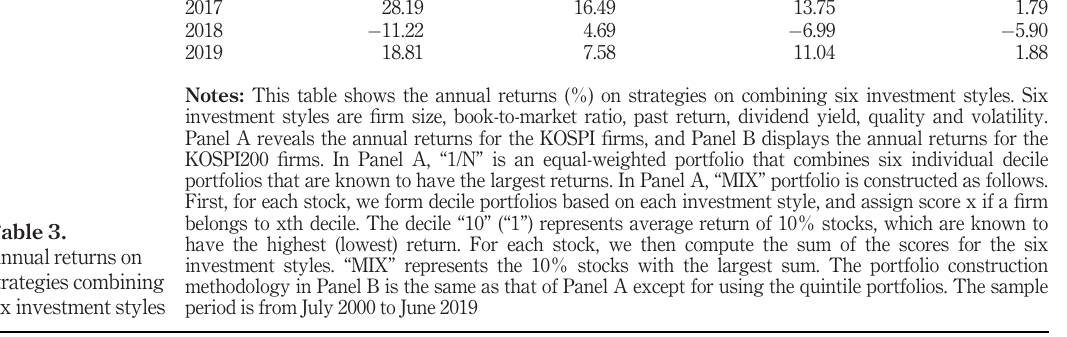
Table 3. Annual returns on strategies combining six investment